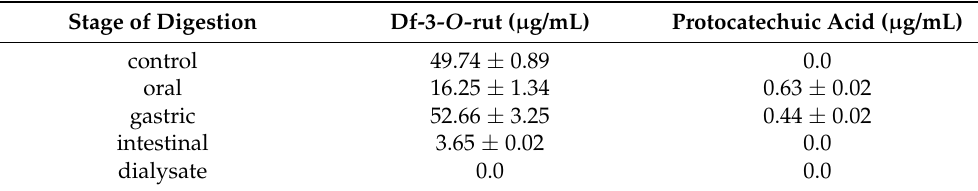
Table 4. The content of delphinidin-3- O -rutinoside (Df-3 -O- rut) and protocatechuic acid at individual stages of the digestion